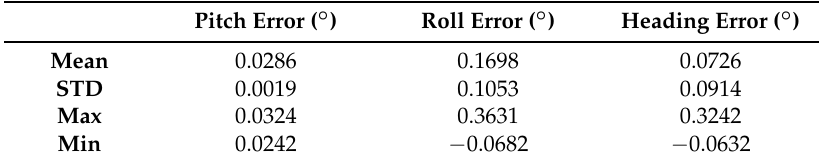
Table 3. Statistical analyses of the attitude errors with the severe sea condition.